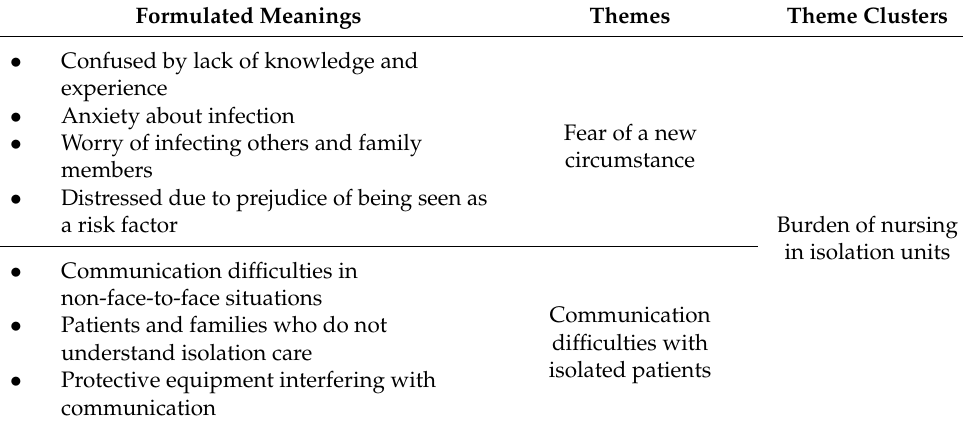
Table 2. Examples of formulated meanings, themes, and theme clusters. Formulated Meanings